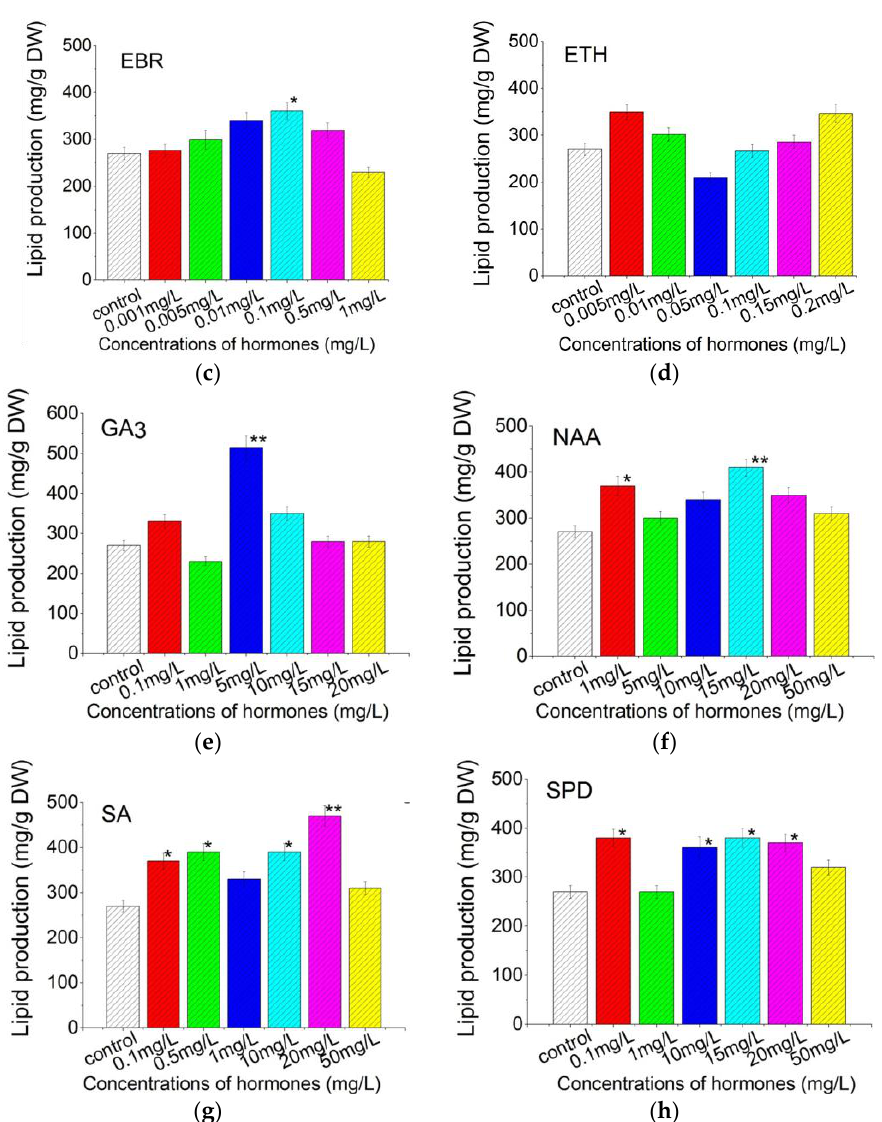
Figure 5. Lipid production by C. pyrenodiosa ZF strain at different concentrations of plant growth regulators: ( a ) 6-BA treatments; ( b ) ABA treatments; ( c ) EBR treatments; ( d ) ETH treatments; ( e ) GA 3 treatments; ( f ) NAA treatments; ( g ) SA treatments; ( h ) SPD treatments.